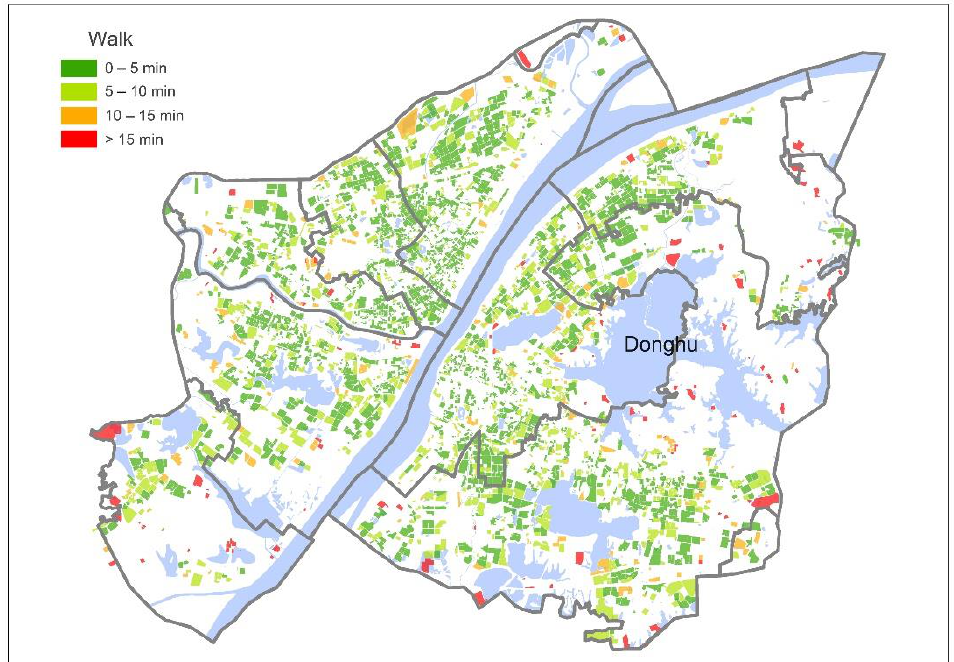
Figure 13. Communities in different time thresholds of the community pharmacies of walking mode.